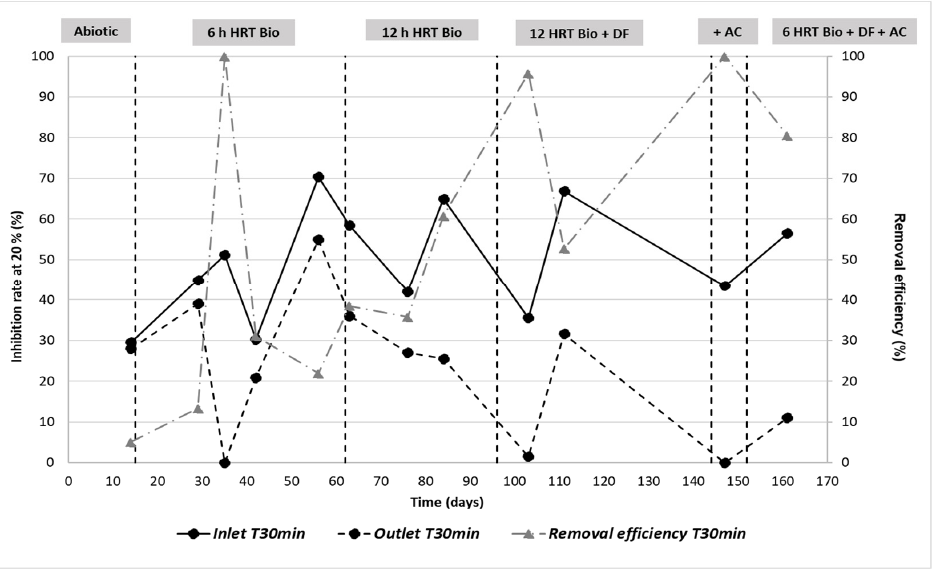
Figure 23. Inhibition rate and removal efficiency at 30 min measured by Microtox over time and phases.